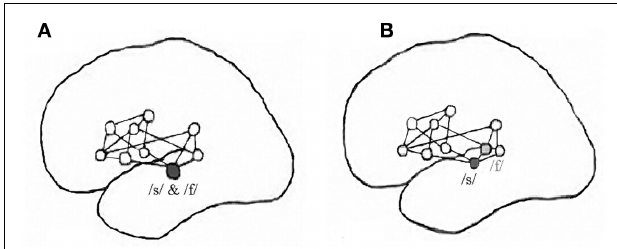
FIGURE 1 |Adapted from Pulvermuller (1999). The network with empty circles represents the basic perisylvian language network that is shared by all words. (A) In pre-readers, the words/fit/and/sit/might be encoded in a similar network where the phonological node that codes for the first phoneme is poorly specified. (B) When children learn to read, part of the ambiguity in the phonological nodes is resolved through the direct link with orthography.The network is restructured accordingly and each phoneme is encoded by a specific